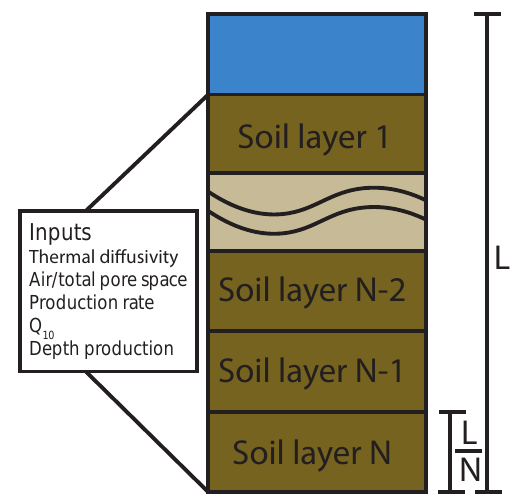
Figure 2. Conceptual representation of the 1-D layered soil model. Overall profile length is denoted with L , and N represents the num- ber of individual layers in the model soil